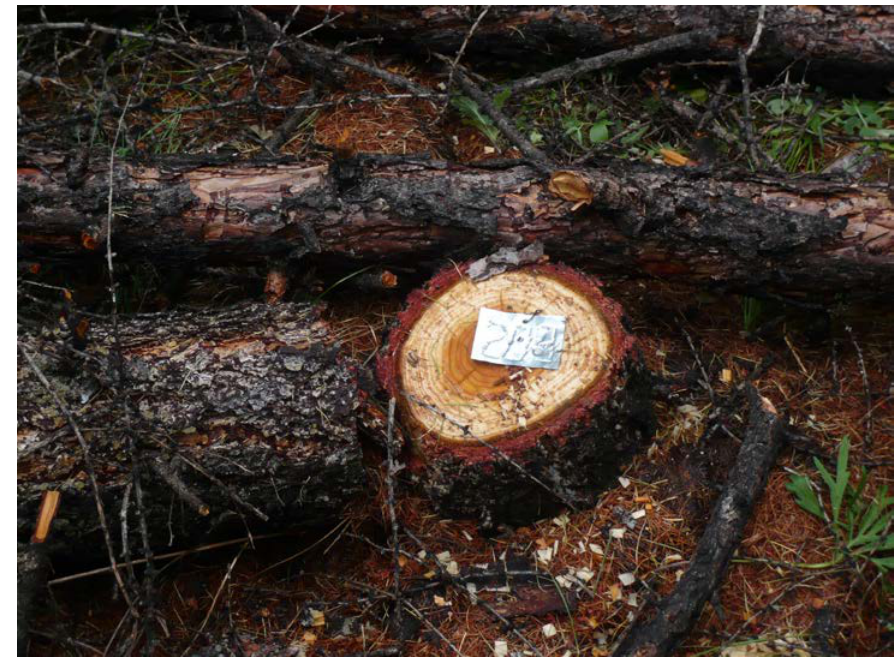
Figure A4. After the thinning 2009: larch stump with the respective tree number.